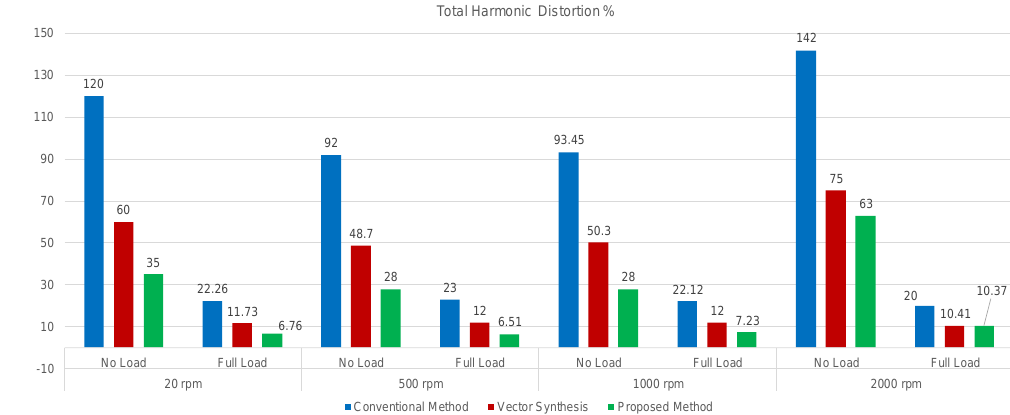
Figure 13. Total harmonic distortions (THD%) in different